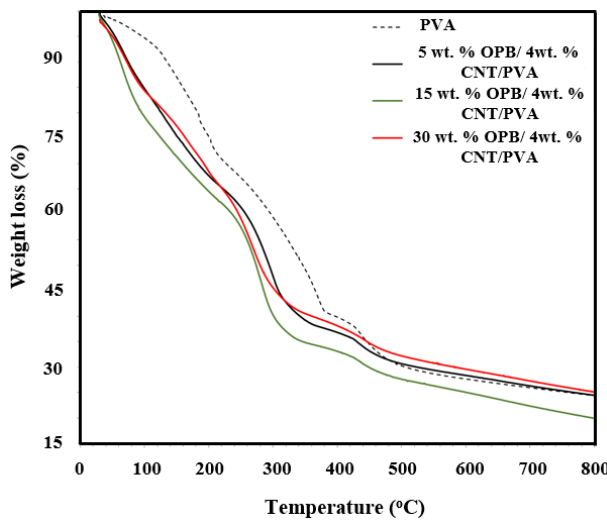
Figure 2. TGA curves of non-reinforced and OPB/MWCNTs reinforced PVA hydrogels.